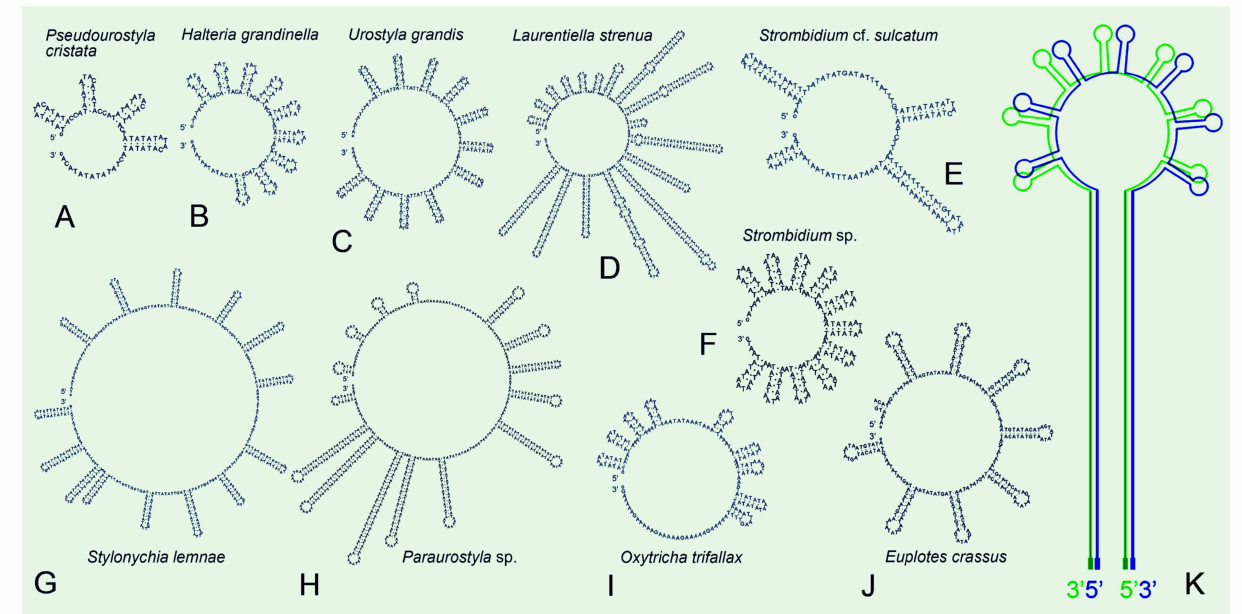
Figure 4. Secondary structures of central repeat regions of mitogenomes in the subclass Hypotrichia ( A – D , G – I ), Oligotrichia ( E , F ), and Euplotia ( J ) based on single-stranded DNA. The general model of mitogenomes of the class Spirotrichea ( K ) inferred from double-stranded DNA is based on the structures of A – J